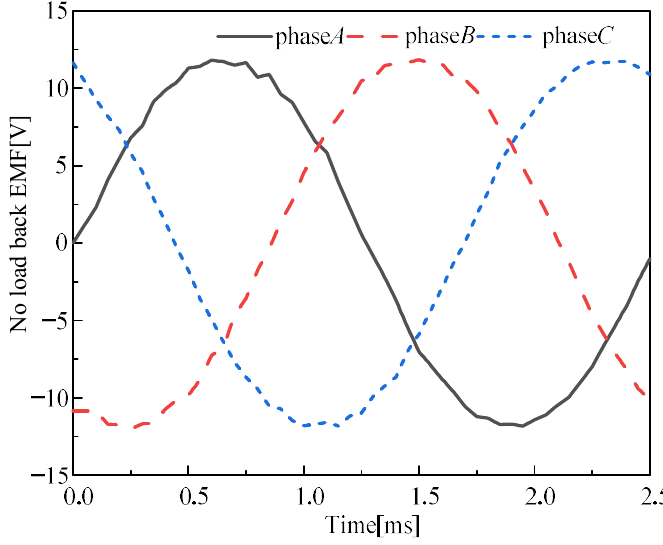
Figure 7. Three-phase no-load back EMF.